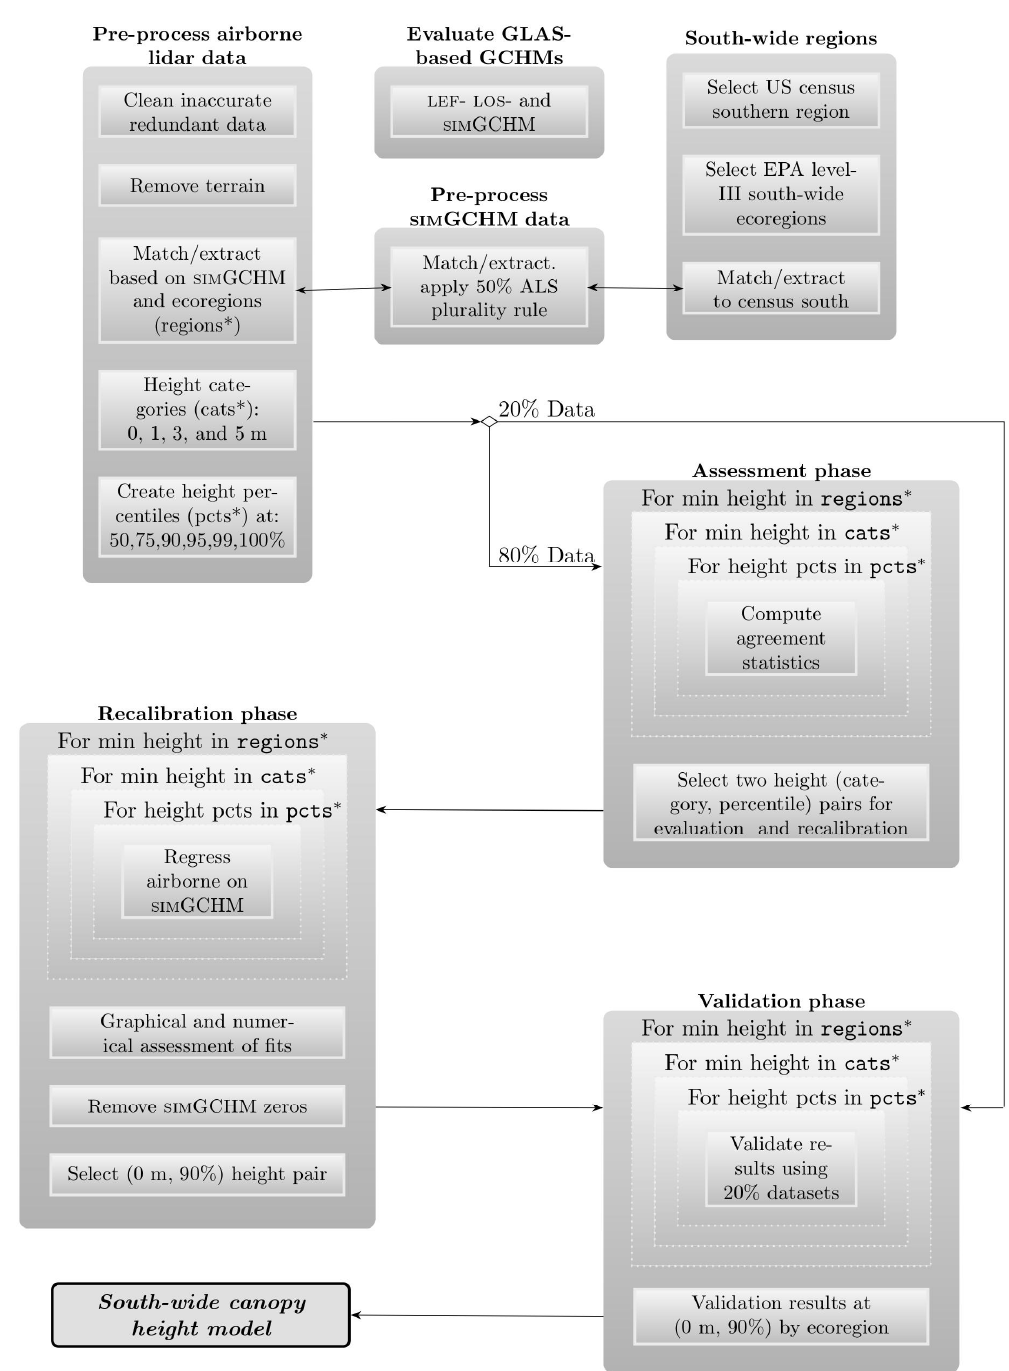
Figure 1. Workflow diagram indicating the interplay between airborne lidar data and simGCHM as data sources, as well as the analysis phases used in the creation of swCHM.